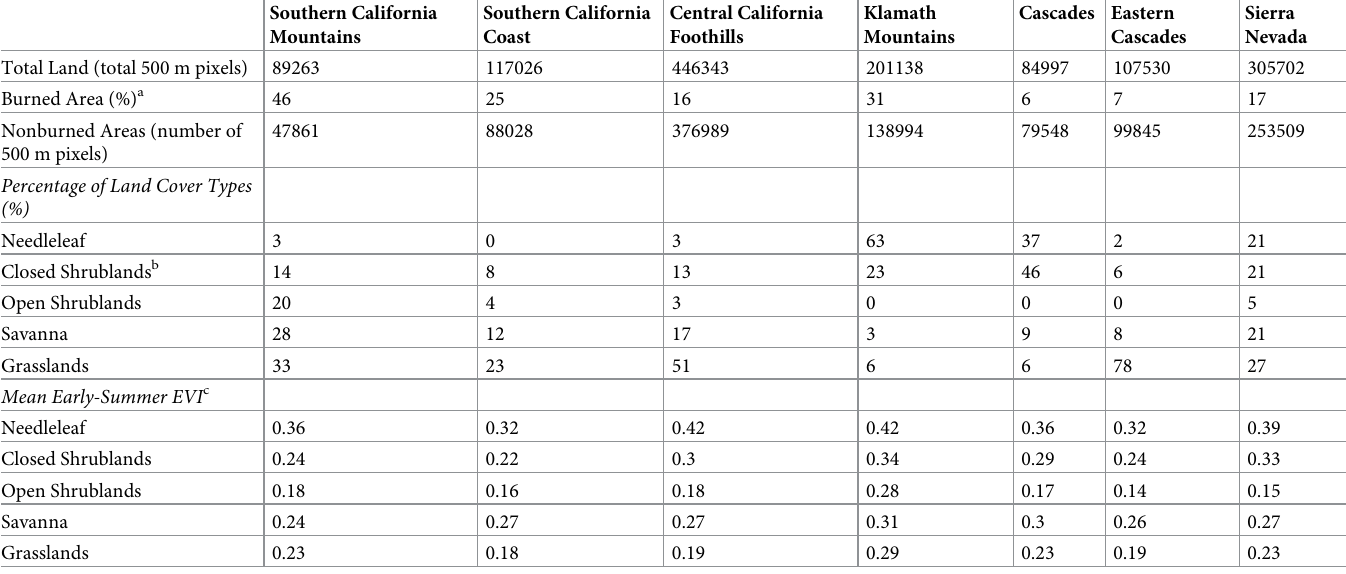
Table 1. Land cover characteristics for the unburned regions of each ecoregion averaged for